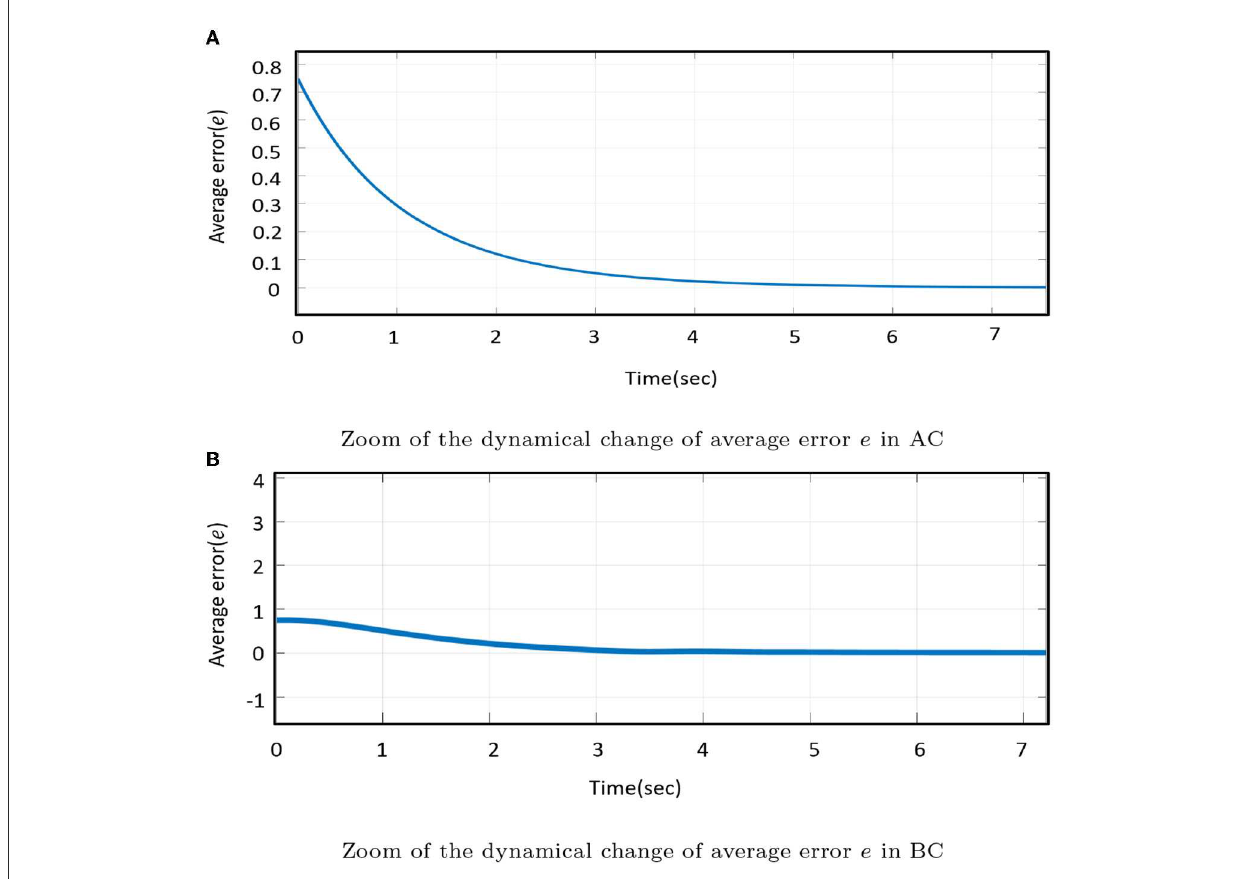
FIGURE15 Effectiveness of the synchronization times for (A) the AC approach and (B) the BC approach with the controller turned on for (0